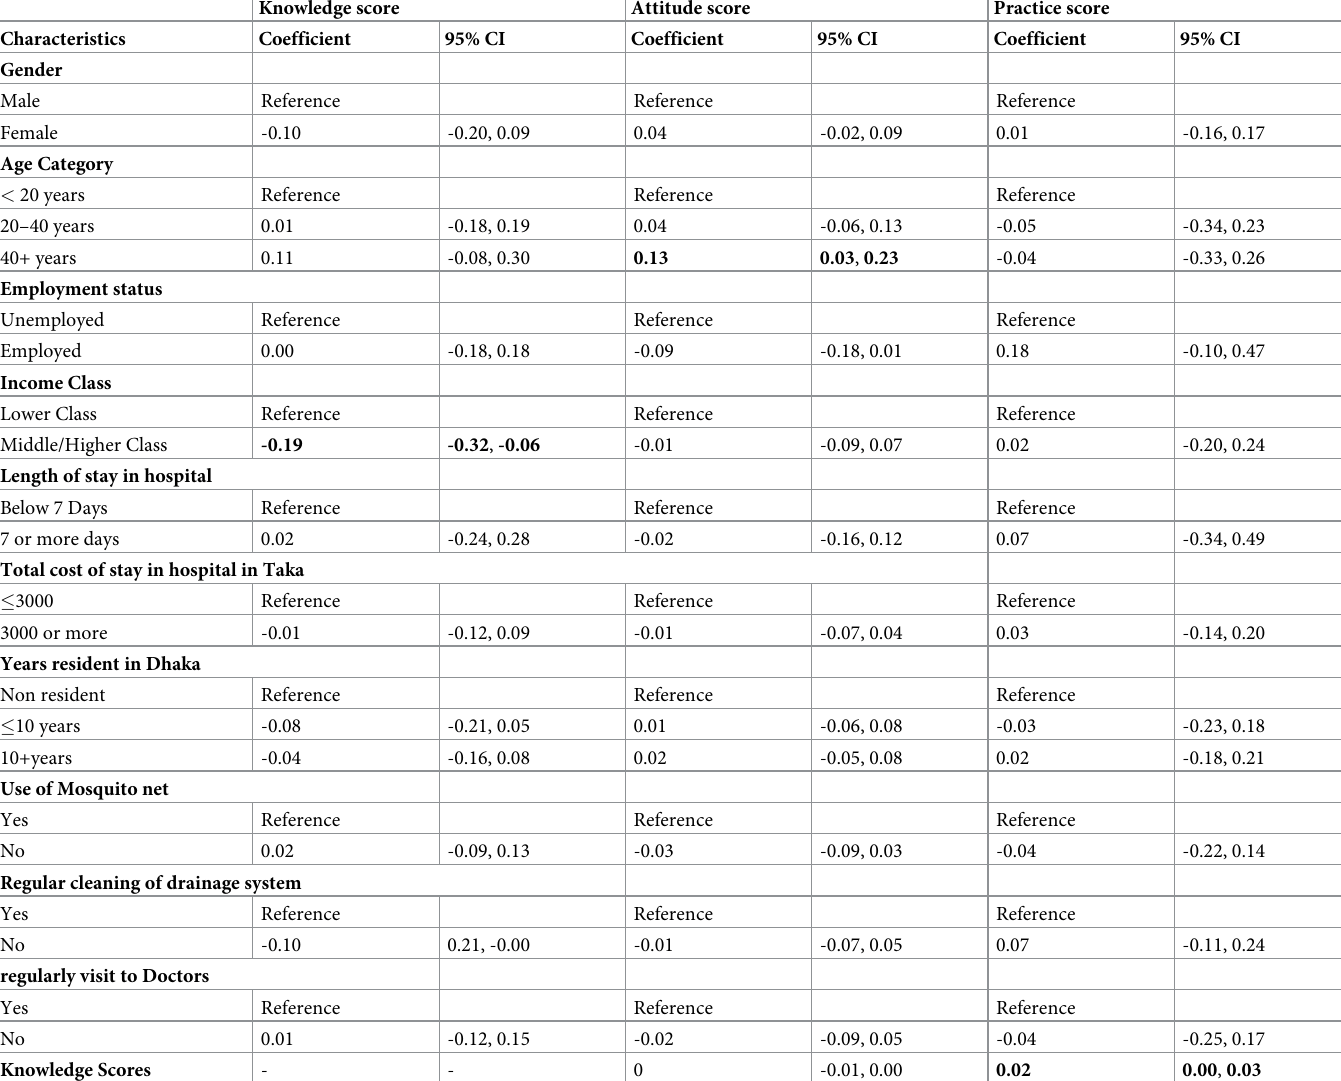
Table 3. Adjusted coefficients and 95% confidence intervals of multivariate analysis for factors associated with knowledge, attitude and practice towards dengue in Dhaka South City Corporation